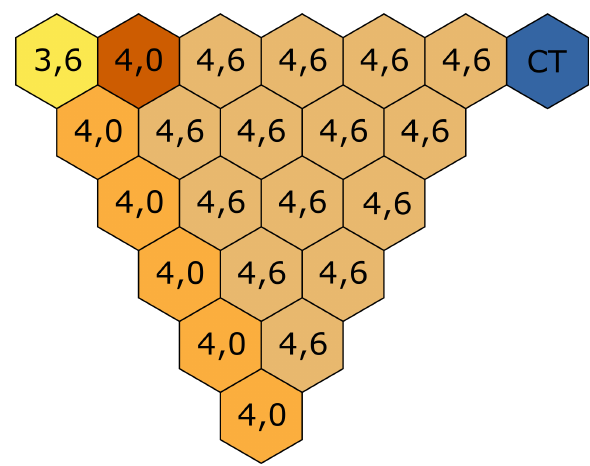
Figure 1. Enrichment of each fuel pin in the Gd2M+ fuel assembly. Numbers mean enrichment in weight fractions and the hexagon with brown color shows position of fuel pin with burnable absorber.